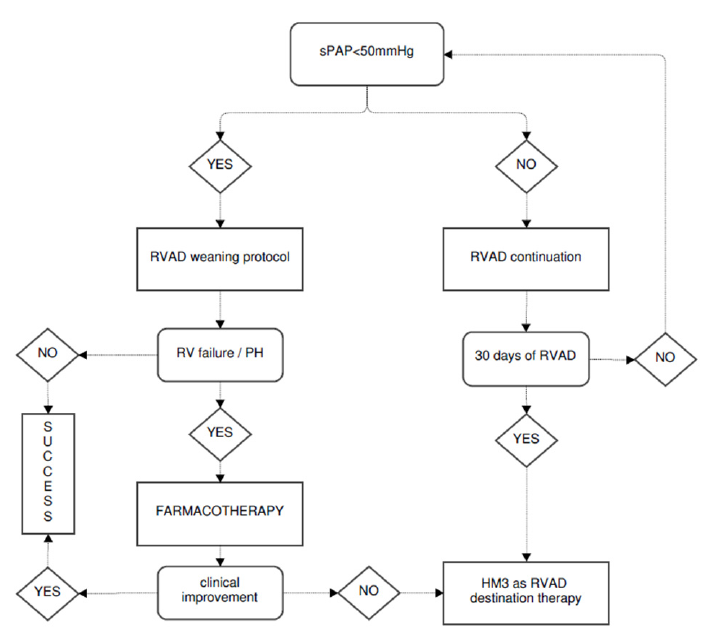
Figure 1. The treatment plan with the tRVAD timeframe.